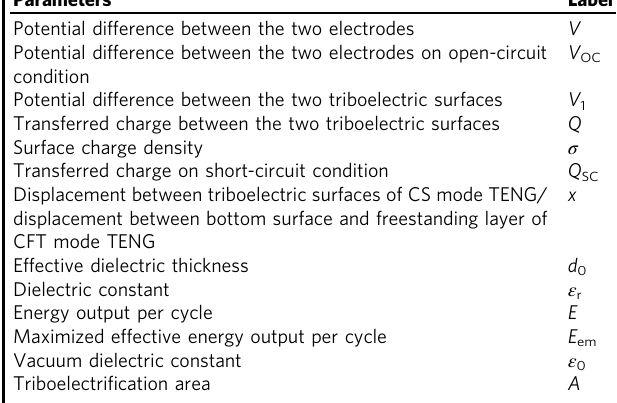
Table. 1 De fi nition of basic parameters of the target TENG (TENG1)